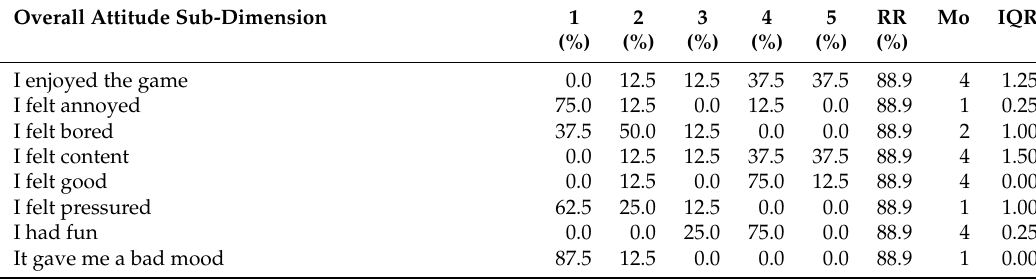
Table A4. MARISA Game feedback—Overall attitude